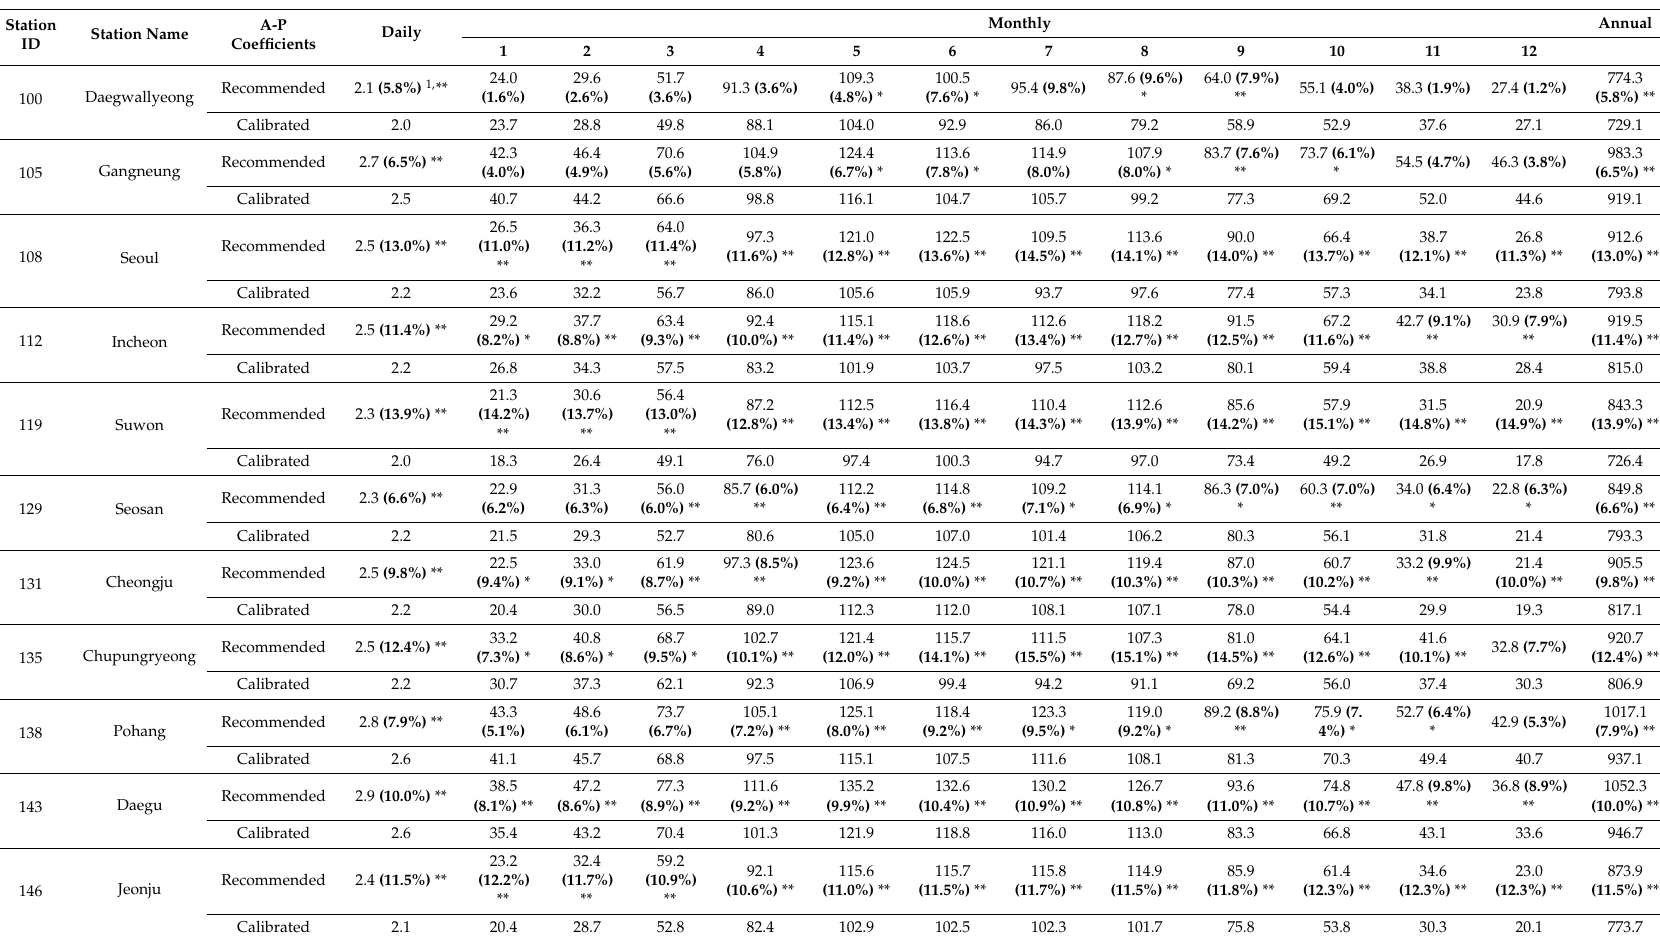
Table 2. Daily, monthly, and annual mean reference crop evapotranspiration (ET 0 , mm) at study sites for a 25-year period (1983–2007), and the difference in estimates between using the recommended and calibrated Ångström–Prescott (A-P)